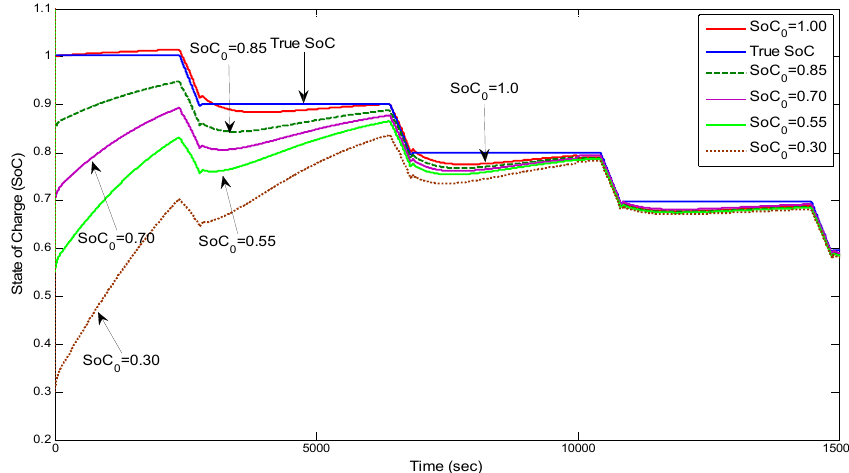
Figure 22. SOC curves for ARX(2,2) + EKF estimation with different initial SOC